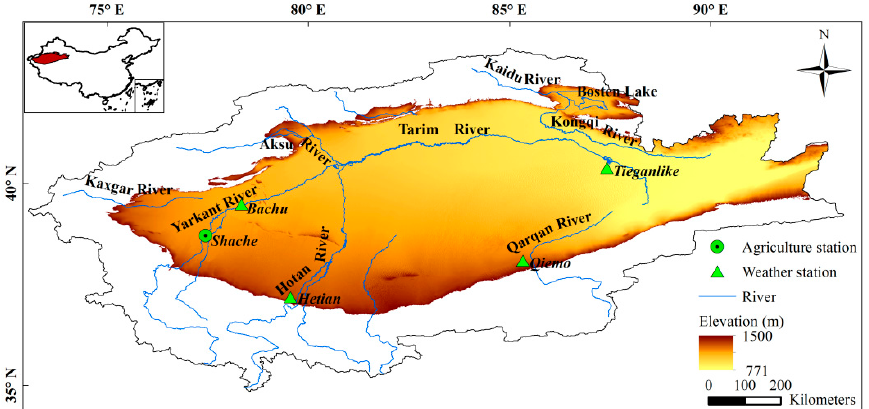
Figure 1. The geographical location of the study area.